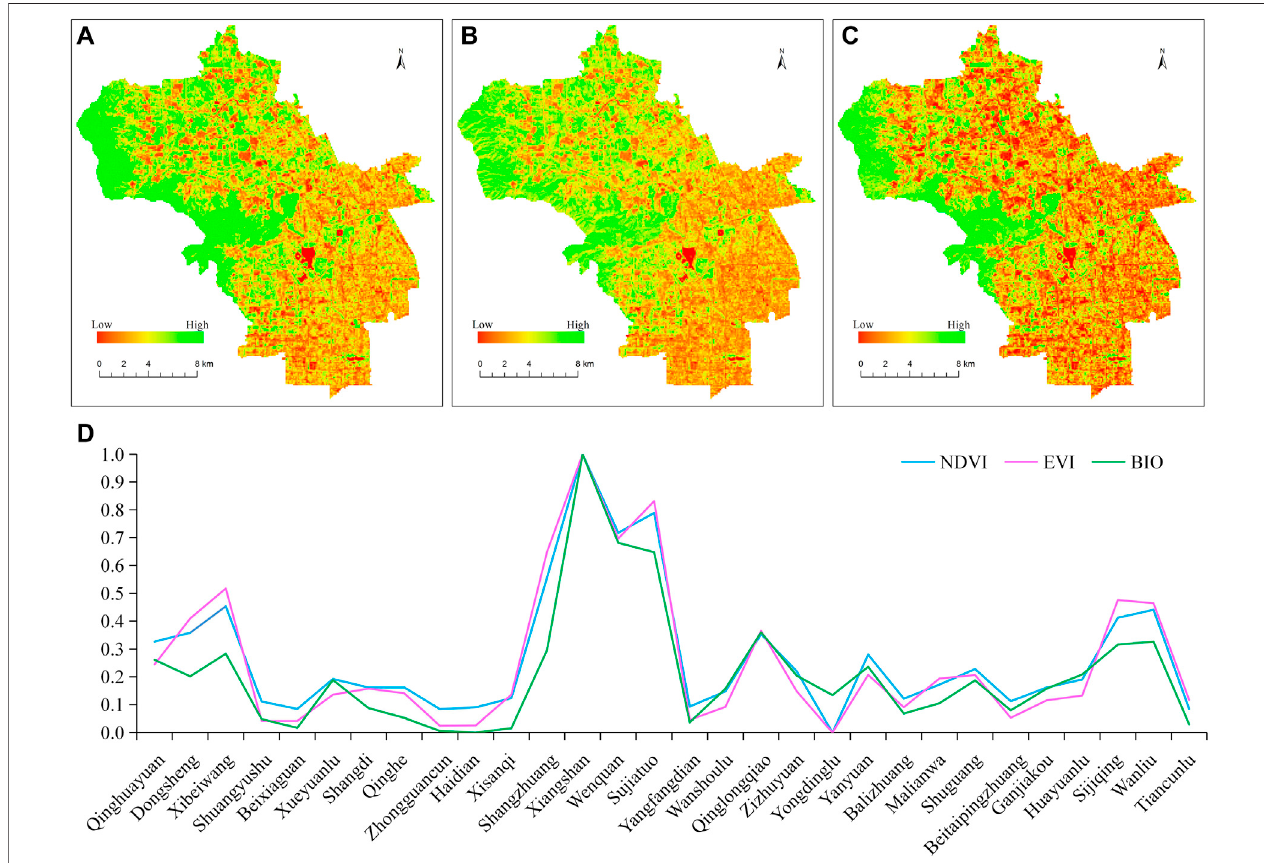
FIGURE 4 | The spatial distribution of NDVI (A) , EVI (B) , and BIO (C) values, and sub-district-wise normalized indices (D) .